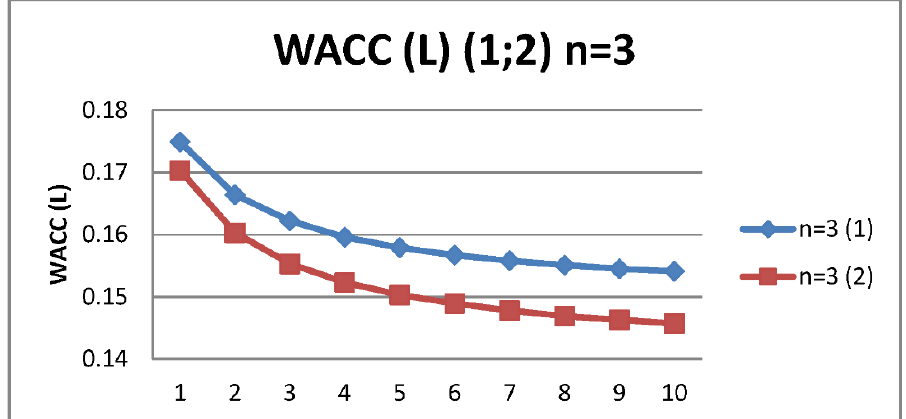
Figure 1. Dependence of the weighted average cost of capital, WACC , on leverage level L in the cases of payments of tax on profit at the end of the year (1) and in the beginning of the year (2) for three-year company.